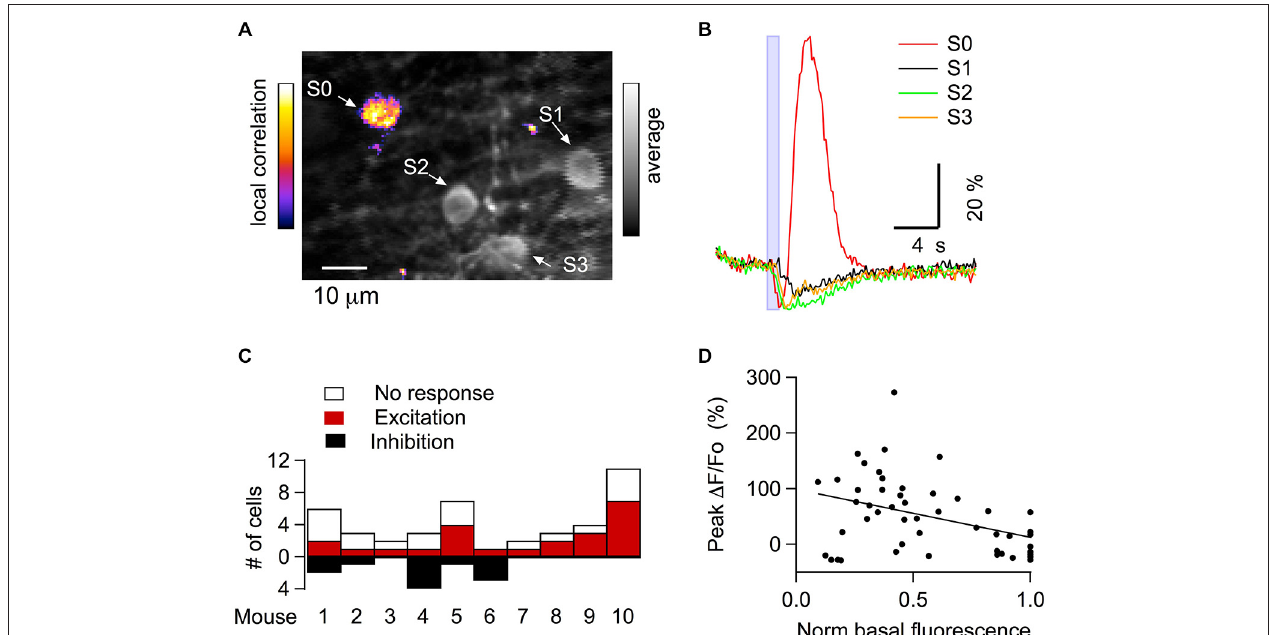
“Materials and Methods” Section). The pipette was located approximately 20–50 µ m above the imaged field. (C) Pooled data showing the distribution of the response type induced by muscimol iontophoresis across animals (10 mice). This analysis was performed only in those experiments in which more than two somata were present in the imaged field. (D) The excitatory effect of muscimol is negatively correlated to the somatic basal fluorescence level. For each field imaged, the pre-stimulus fluorescence levels for all somata were normalized to the value of the highest soma in the field (solid line: linear regression fit; regression coefficient = − 0.41; p < 0.001; pooled data from 10